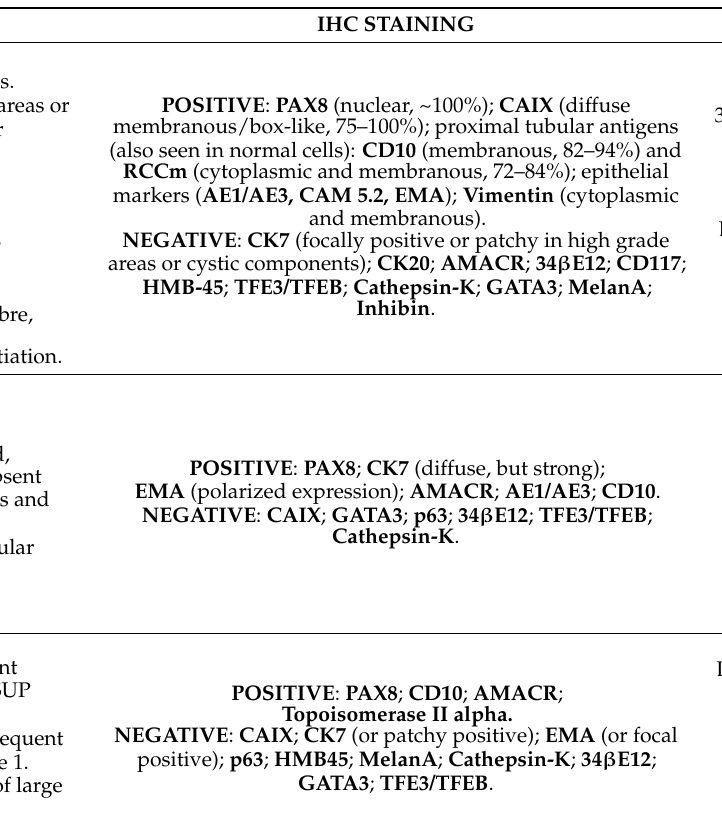
Table 1. Summary of evidence regarding RCC histological, IHC, and genetic profiles